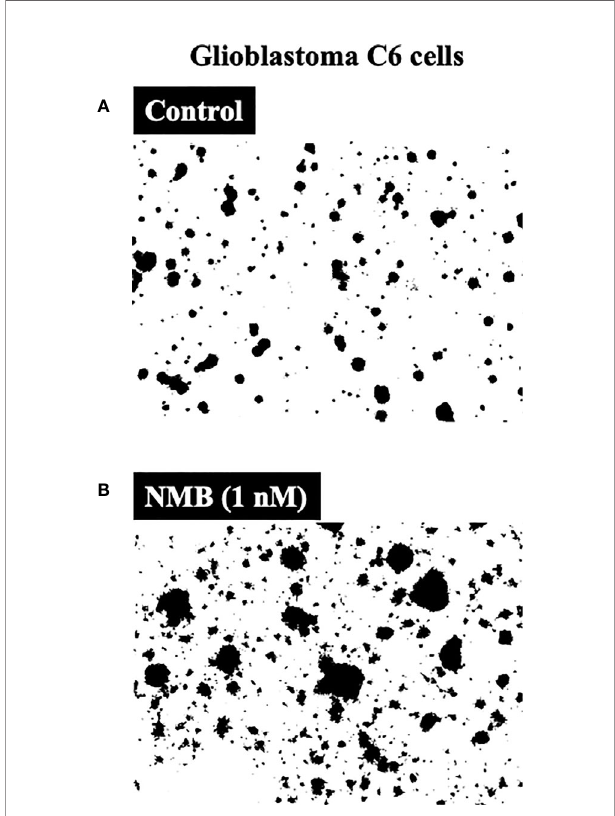
FIGURE 2 | Ability of neuromedin B to stimulate growth of Glioblastoma C6-cells (bottom, panel B ) compared to control (top, panel A ). NMB (1 nM) stimulated a 177% increase (colony number increase from 74 ± 2 to 205 ± 9). Figure is drawn from data in